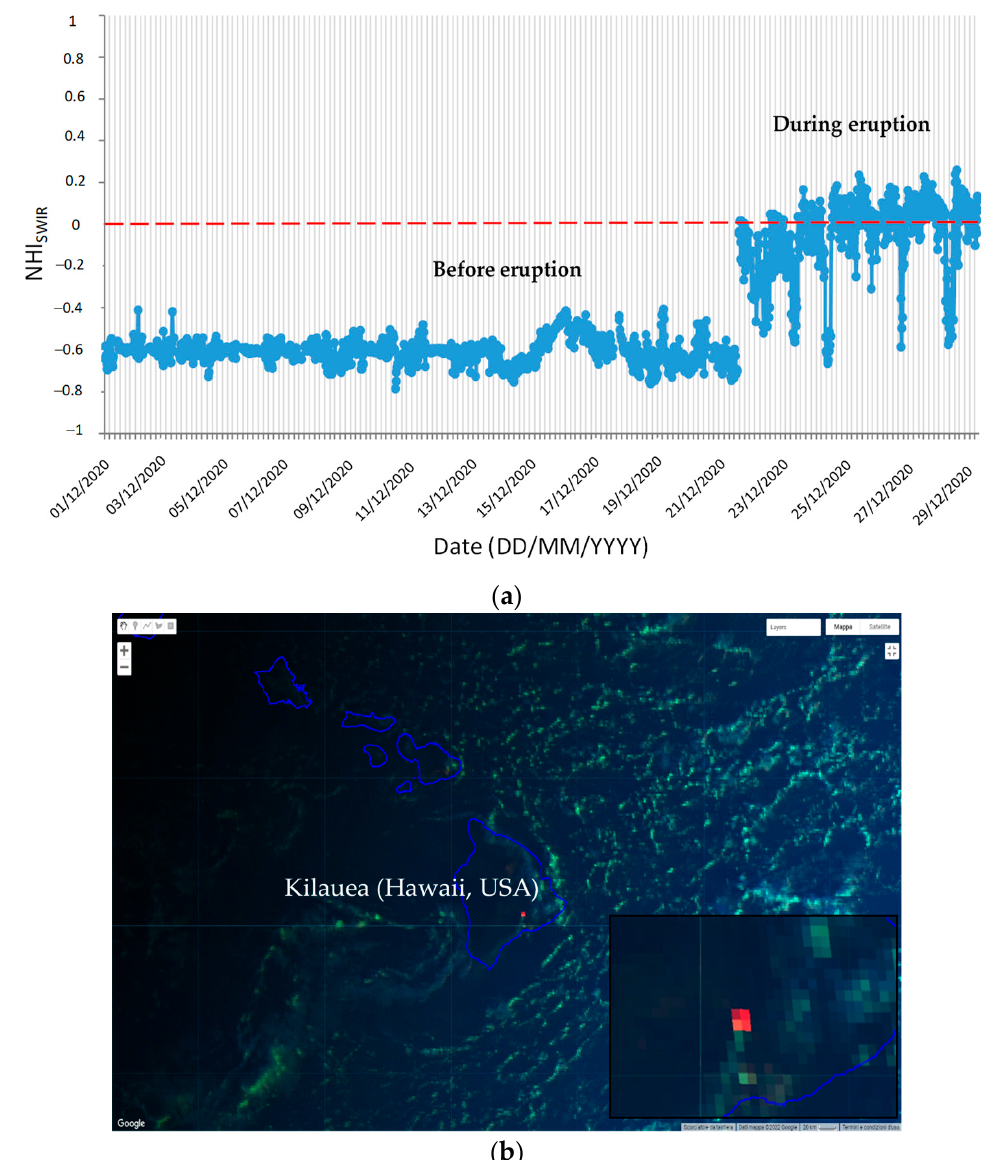
Figure 7. ( a ) Time series of the NHI SWIR index retrieved, from daytime GOES-17 ABI data (06:00 − 17:00 LT), at 10 min time interval, of 18 December at 16:00 UTC–23 December at 23:50 UTC, over the Kilauea (Hawaii, USA) crater area; ( b ) GOES-17 RGB (Red = band 6; Green = band 2; Blue = band 1) image of 21 December at 17:00 UTC (21 December at 07:00 LT) showing, in red, the thermal anomaly at Kilauea (magnified on bottom right corner) leading to positive values of the NHI SWIR index.